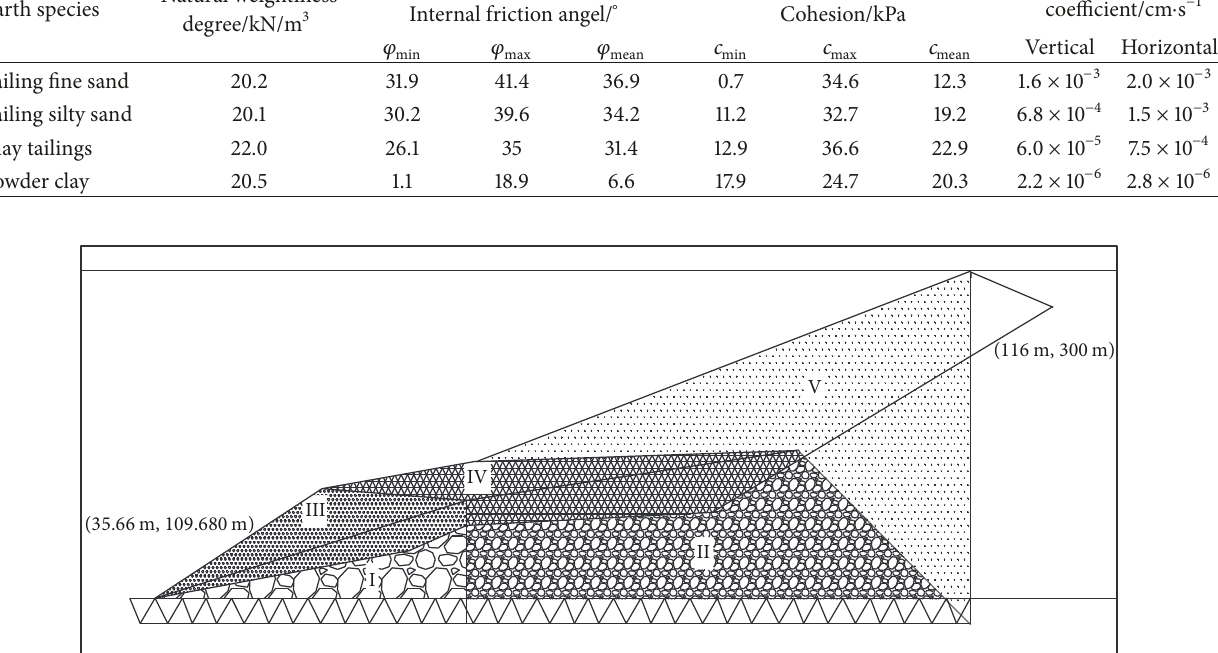
Figure 4: Cross section map of tailing dam of Panzhihua: I, II, III, IV, and V indicate the regions of rock fill, tailing fine sand, tailing silty sand, clay tailings, and powder clay,